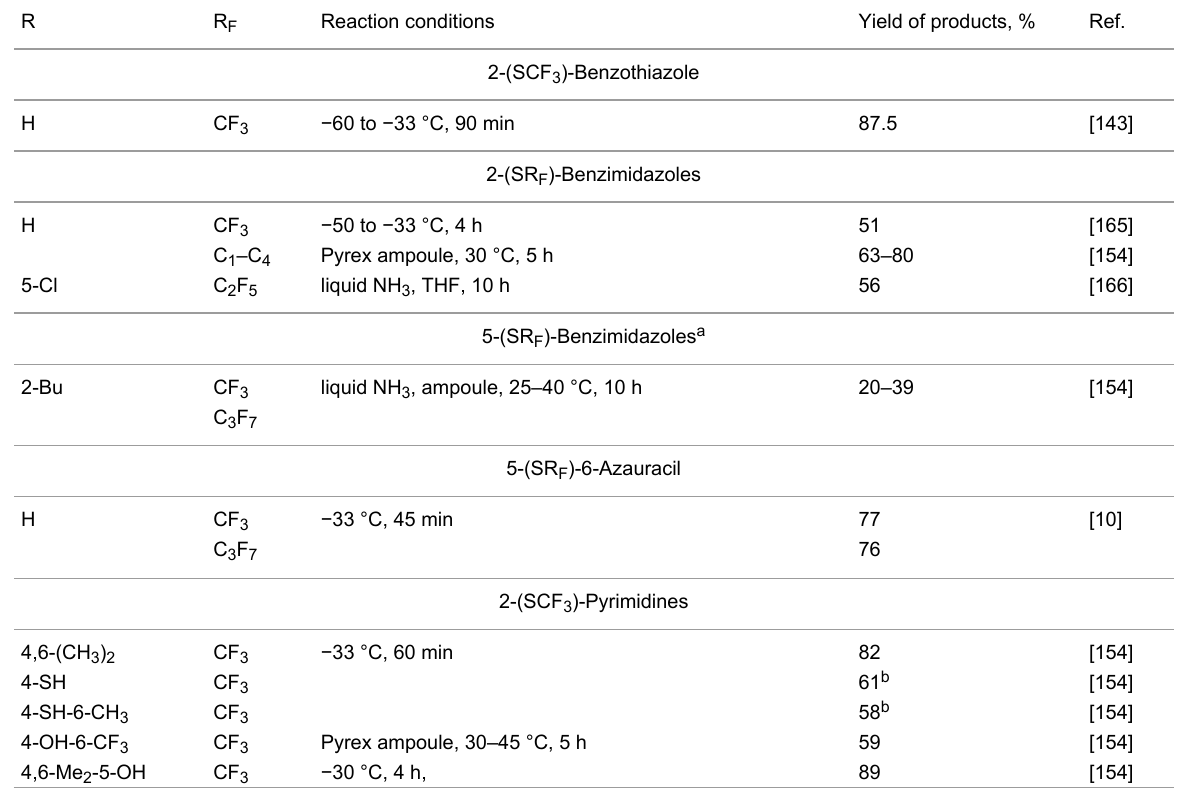
Table 3: S -Perfluoroalkylation of heterocyclic compounds under UV irradiation of heterocycles thiols R-Het-SH in liquid ammonia. R R F Reaction